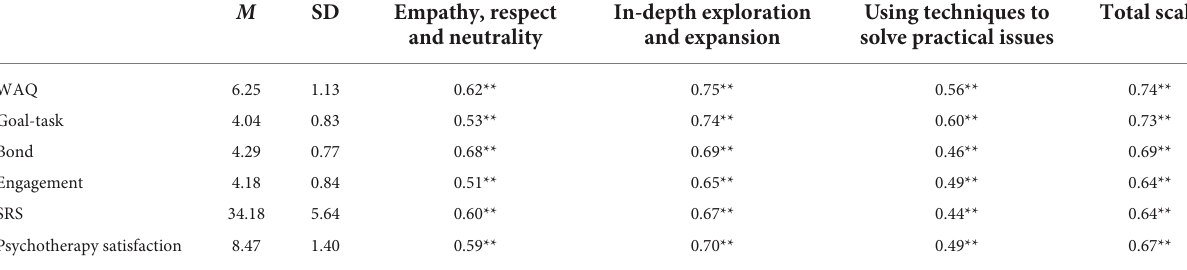
TABLE 5 Concurrent validities of